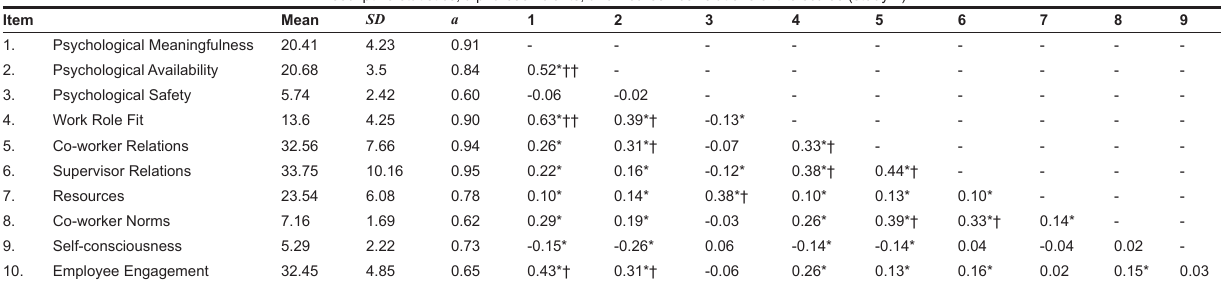
TABLE 3 Descriptive statistics, alpha coefficients, and Pearson correlations of the scales (study